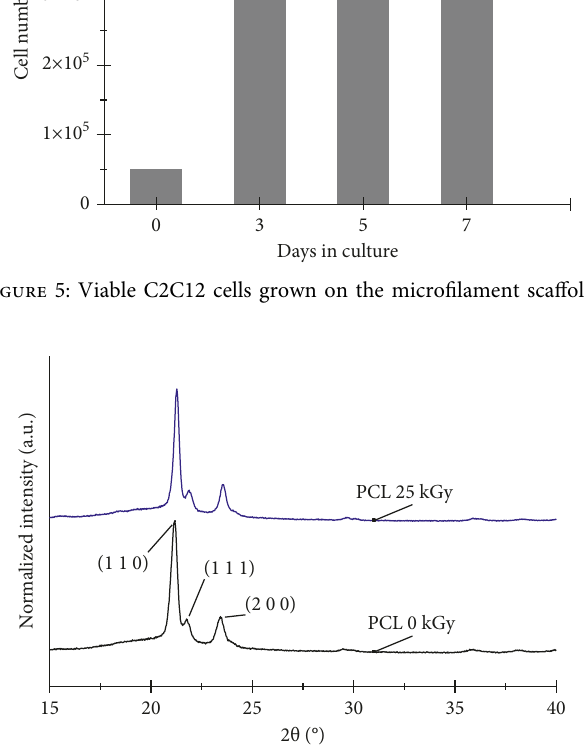
Figure 6: Diffractograms of (a) nonirradiated PCL and (b) irradiated PCL.